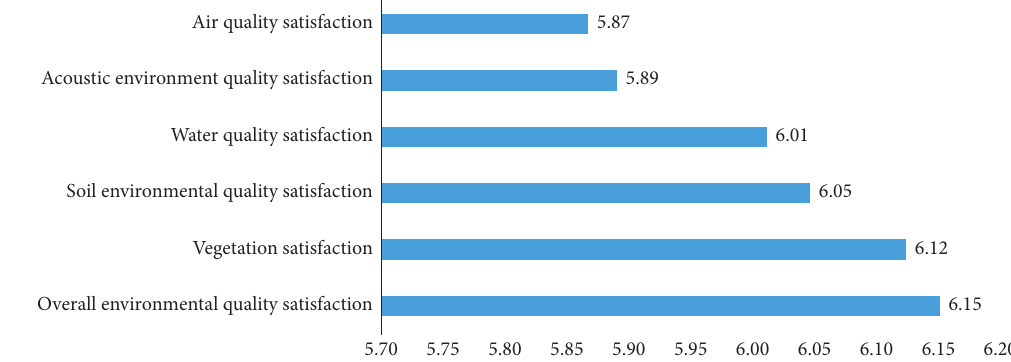
Figure 1: Environmental quality satisfaction